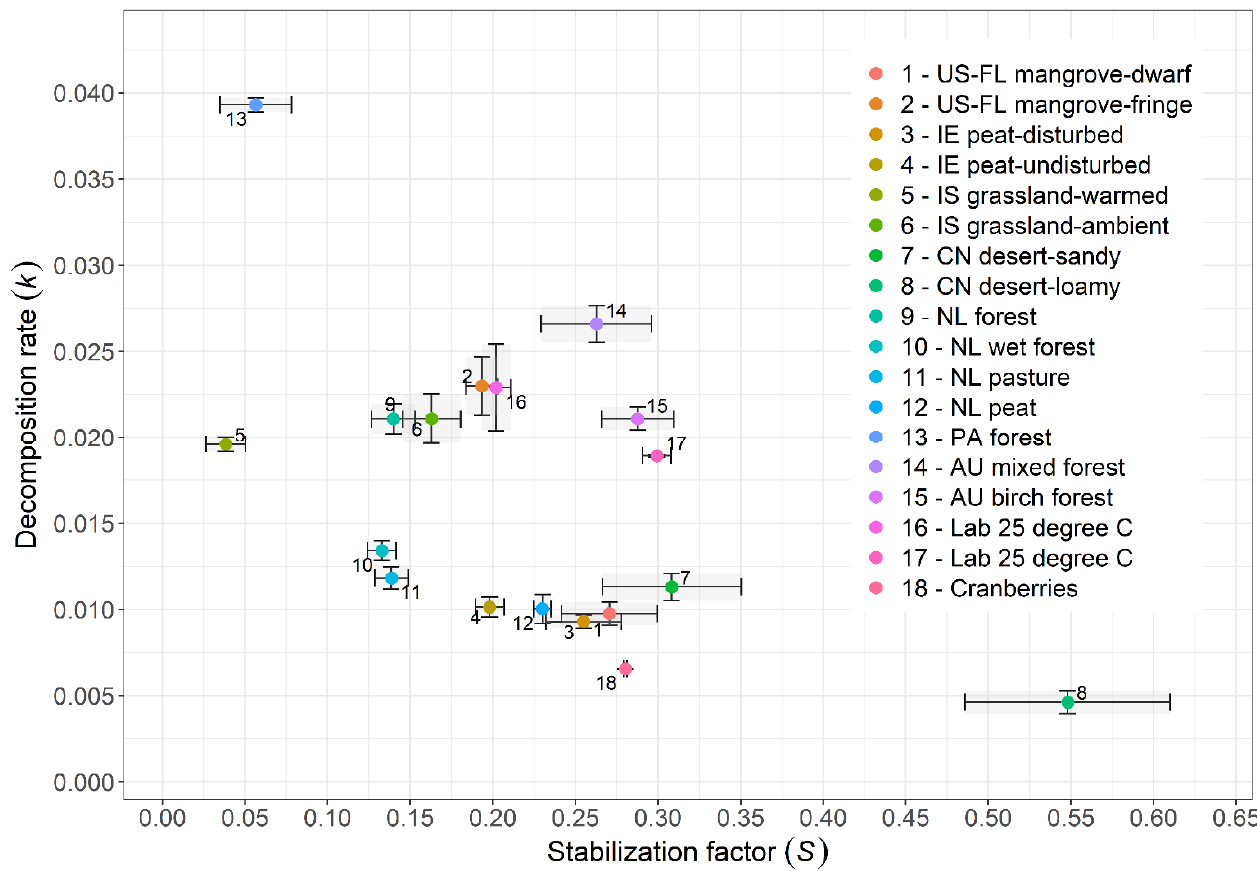
Figure 5. TBI of Quebec cranberry agroecosystems compared to the TBI of terrestrial ecosystems reported by Keuskamp et al. (2013). United States–Florida = US-FL, China = CN, Panama = PA, the Netherlands = NL, Austria = AU, Ireland = IE, and Iceland = IS.